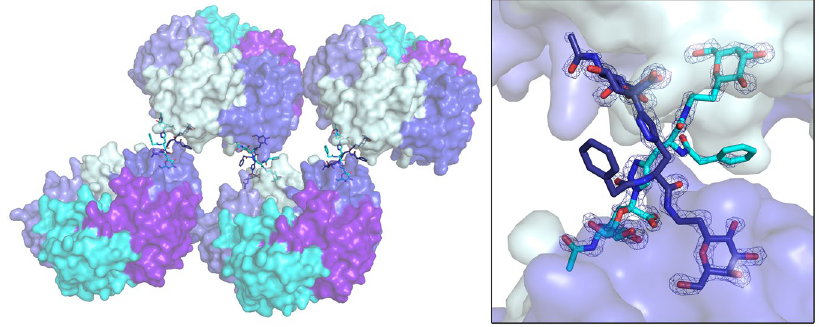
Figure 4. Cross-linking of toxin B-pentamers by 3 in the crystal structure. The toxins are shown in surface representation, with the inhibitor in cyan and dark blue sticks. The inset shows a close-up view of the binding interaction, with two antagonists (cyan and dark blue sticks) bridging two adjacent toxins. The σ A –weighted F o - F c electron density map is shown for both inhibitors (contoured at 3.0 σ , generated before modelling the ligand). The figure was prepared with MacPyMol (Schrödinger LLC (www.schrodinger.com/pymol); version